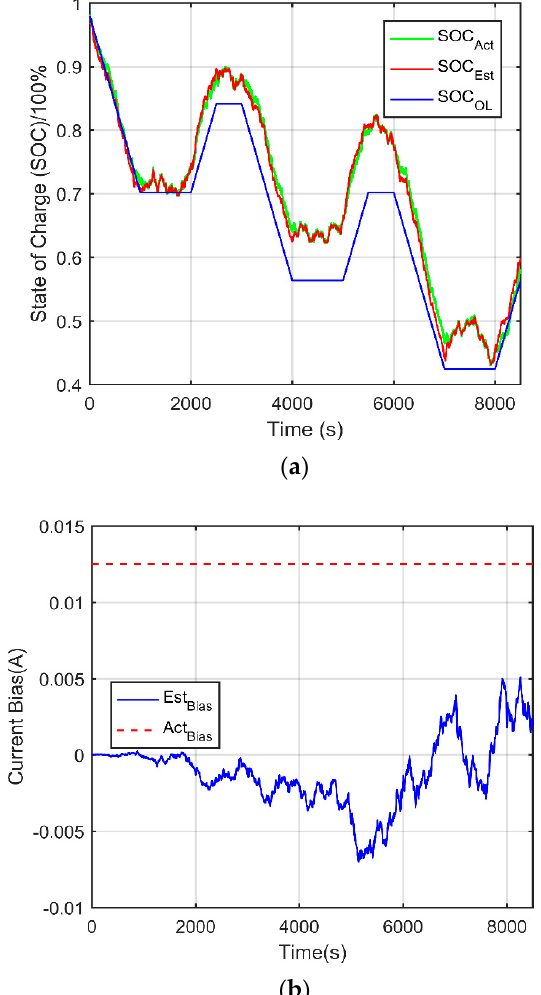
Figure 5. Results for DEKF model with current noise of 0.0125A: ( a ) DEKF based state of charge (SOC) estimation; ( b ) DEKF based parameter estimation.